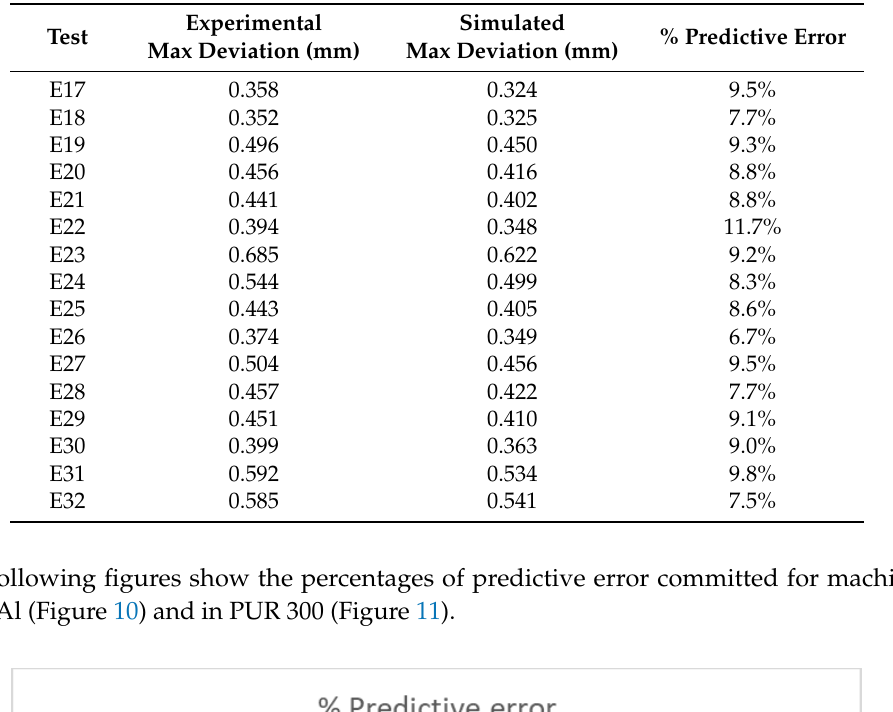
Table 5. SEMPAD for PUR 300.